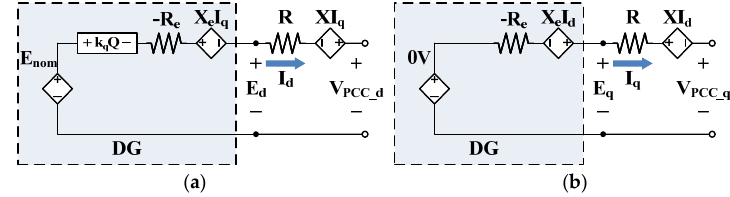
Figure 6. d ‐ q equivalent circuits for line impedance estimation: ( a ) d ‐ axis; ( b ) q ‐ axis. Figure 6. d-q equivalent circuits for line impedance estimation: ( a ) d-axis; ( b )